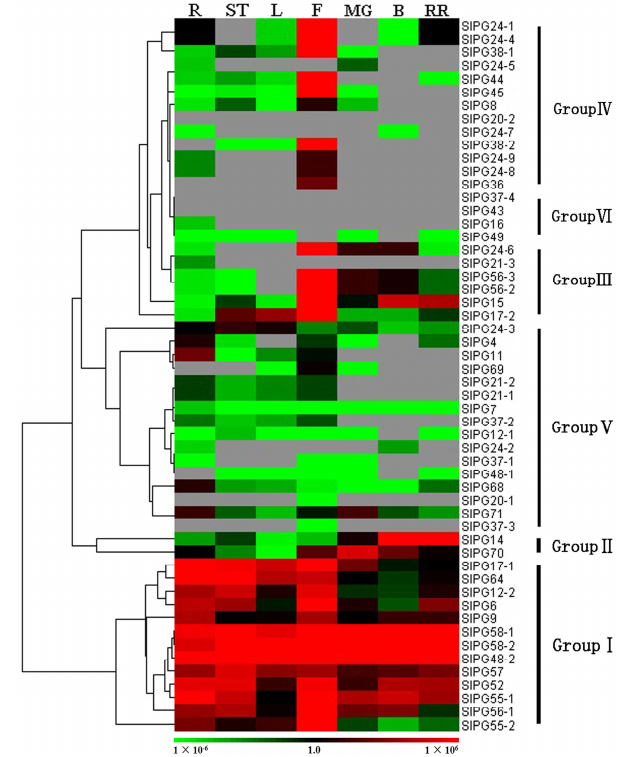
Figure 4. Hierarchical clustering and heat map generated by Cluster 3.0 showing the expression levels of SlPG genes among different tissues of S. lycopersicum . The scale bars represent relative expression level. The bright green, bright red, and black shading indicate relatively low, high, and medium expression respectively. The grey shading designates undetectable expression. The vertical dark bar on the right illustrates the six groups of SlPG genes. Different groups are named according to the method used in previous studies [12]. R: roots, ST: stems, L: leaves, F: flowers, MG: mature green fruit, B: breaker fruit, RR: red ripening fruit.